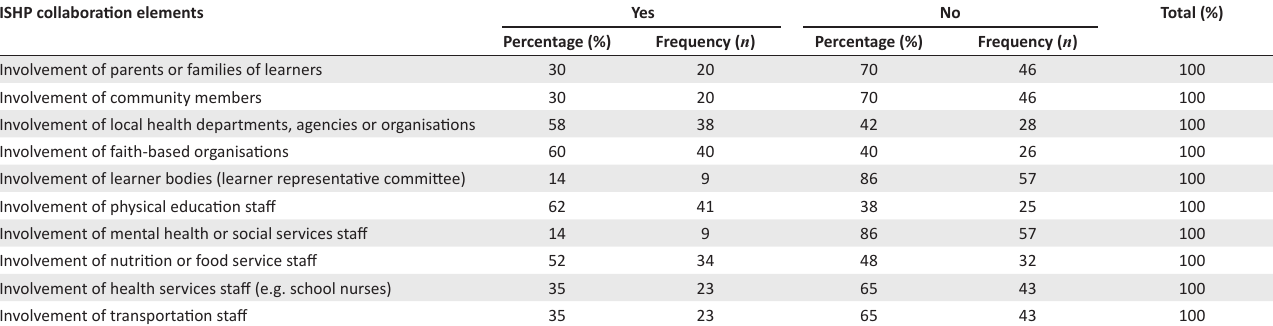
TABLE 2: Integrated School Health Policy (ISHP) multidisciplinary and multisectoral collaboration ( N = 66). ISHP collaboration elements